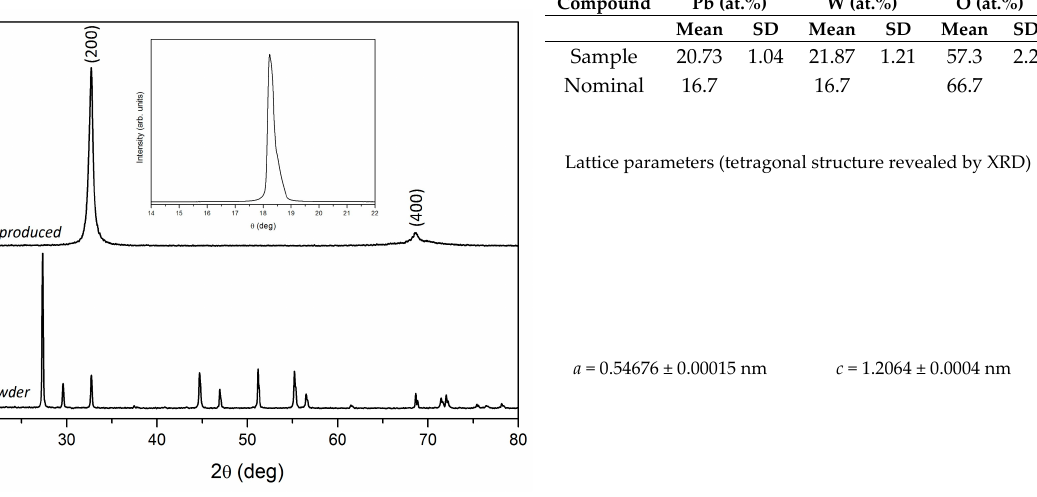
Figure 7. XRD patterns (left) from as produced sample and powder, which was obtained by grinding a small piece of crystal. From peak angular position and relative intensity, PWO crystallographic structure and lattice parameters were calculated. Inset shows the rocking curve of the (200) peak, which reveals misalignment of this lattice plane to the sample surface. The associated Table 2 (right side, top) reports the PWO elements’ atomic concentration as a mean value and standard deviation (SD), evidencing slight variations from the nominal values. Table 2 (right side, bottom) reports the lattice parameters of the PWO tetragonal structure.